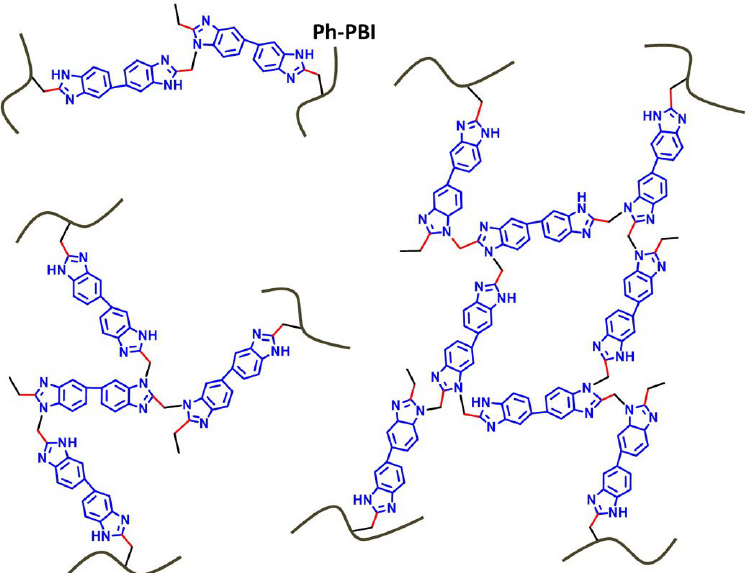
Figure 8. The cross-linked structure of 2BIM-2Cl in Ph-PBI (taken from Ref.